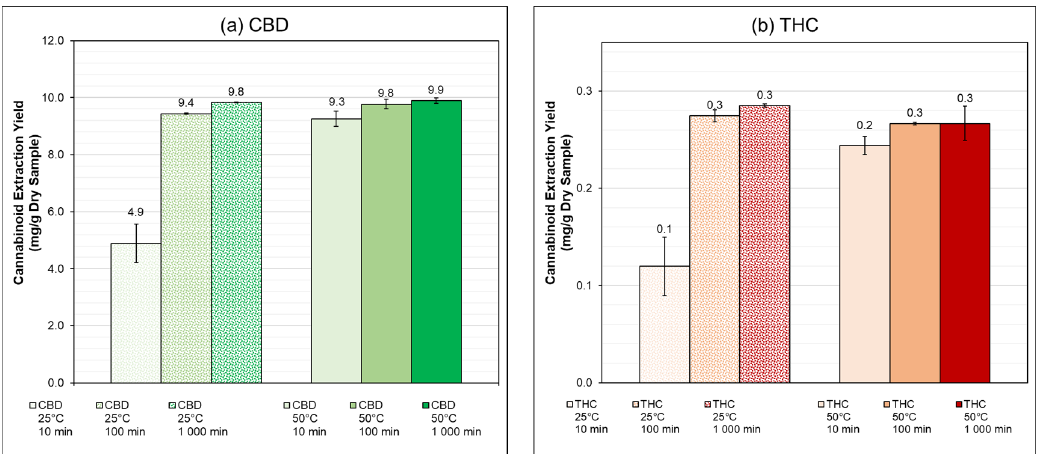
Figure 1. Cannabinoid extraction yield of the experiments performed in Schott flasks (Section 2.3,